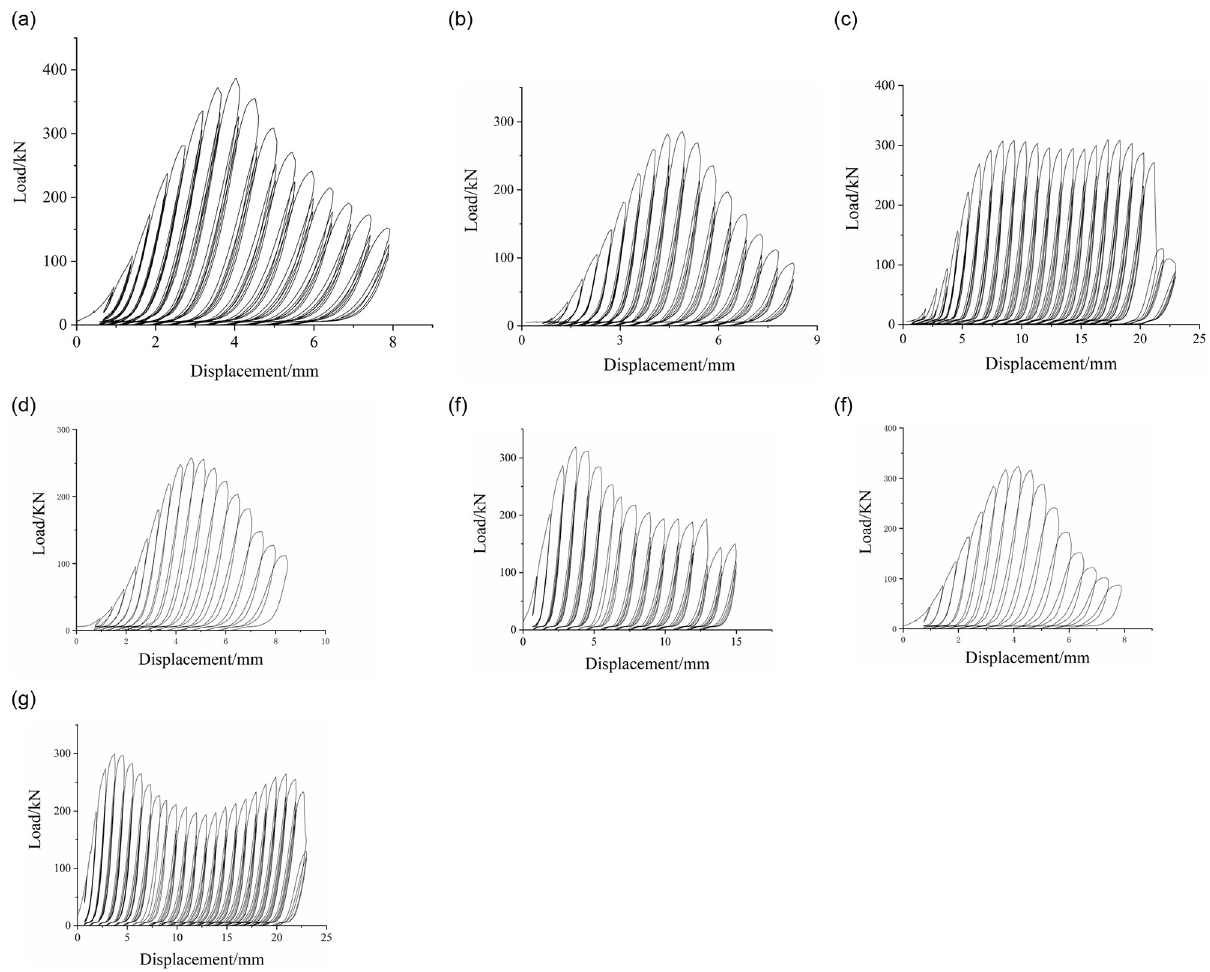
Fig 7. Load-displacement curves of specimens. (a)C1W-1. (b)C2W-1. (C)C3S-1. (d)C4W-1. (e)C5S-1. (f)C6W-1. (g) C7S-1.